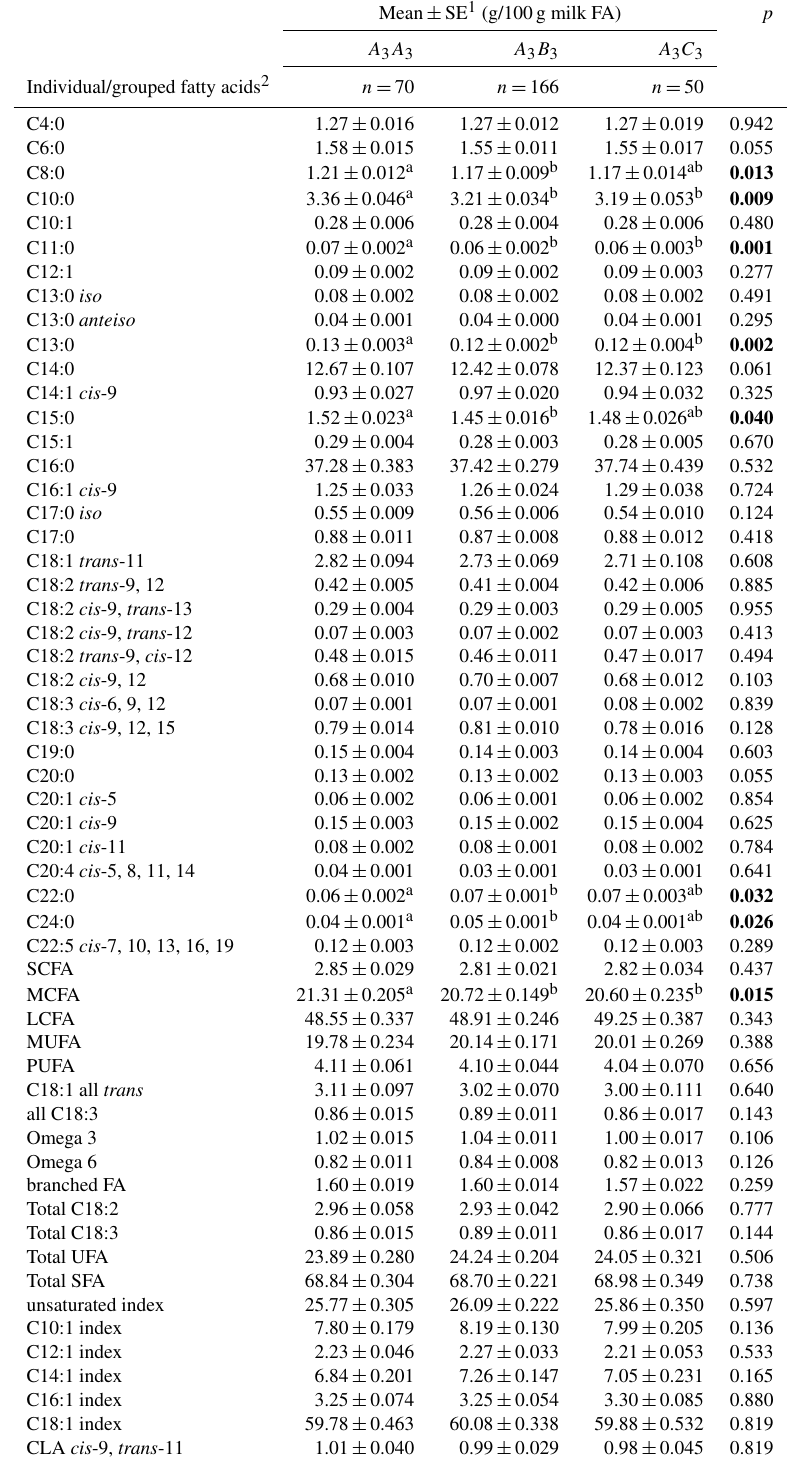
Table 2. Associations between milk fatty acid levels and leptin